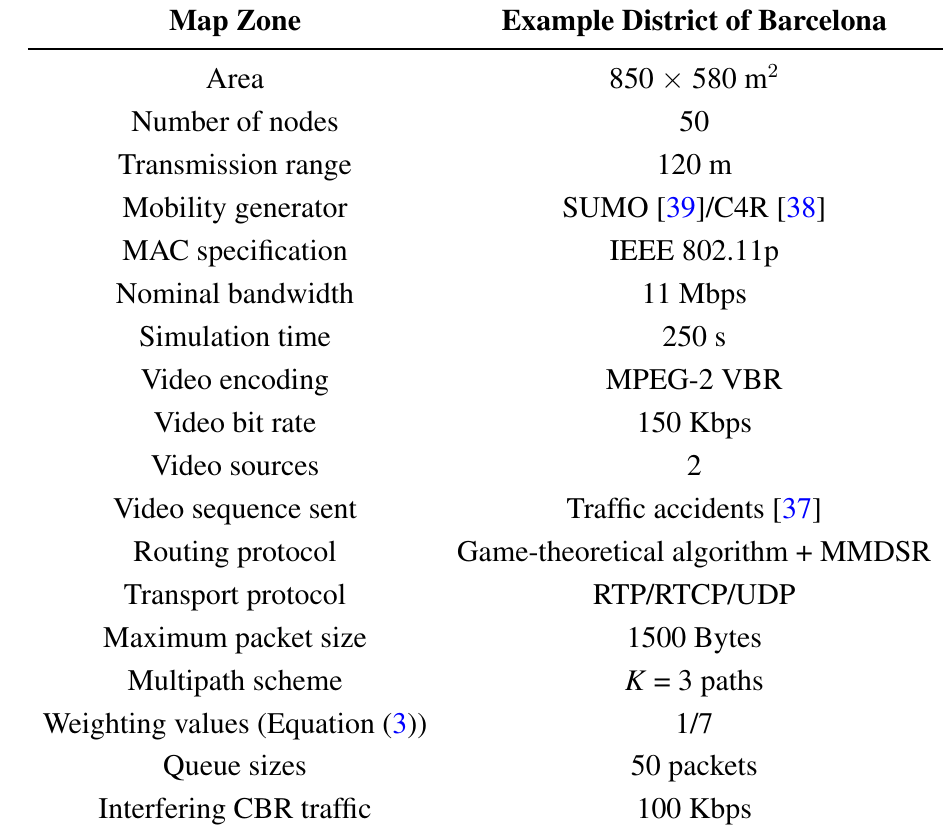
Table 6. Simulation settings of the VANET